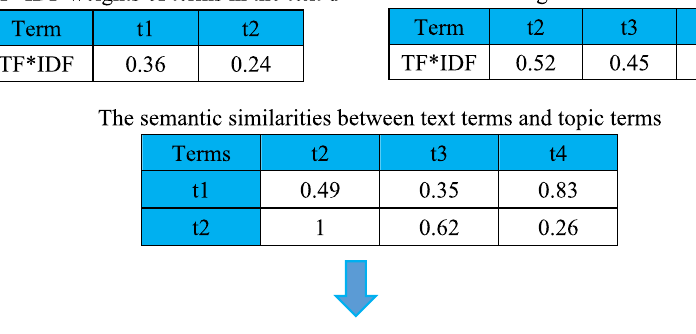
Fig. 5 An example of the